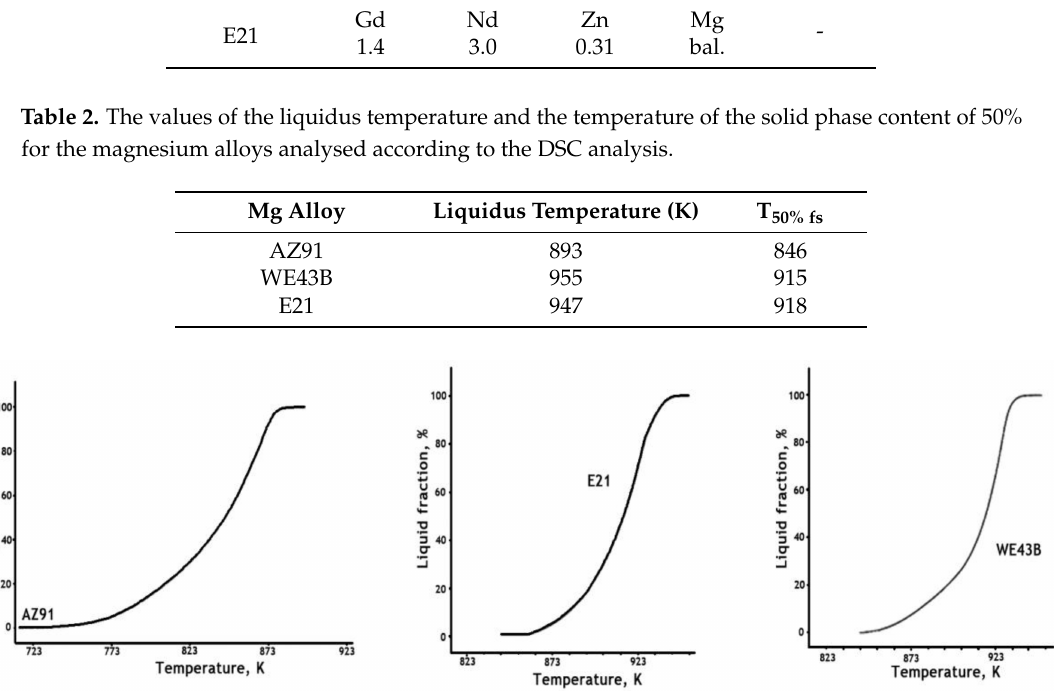
Figure 1. Graphs of DSC analysis of the magnesium systems analysed: AZ91, E21 and